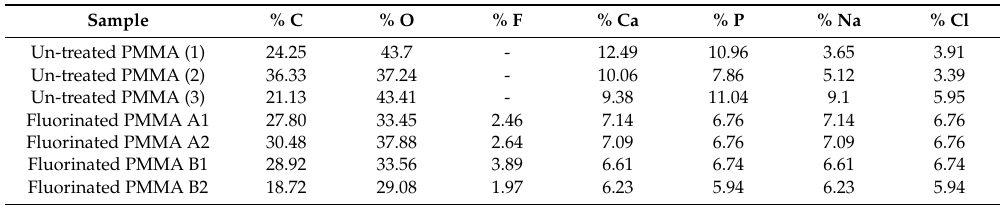
Table 5. XPS data for untreated and plasma-treated PMMA samples after immersion in Simulated Aqueous Humour